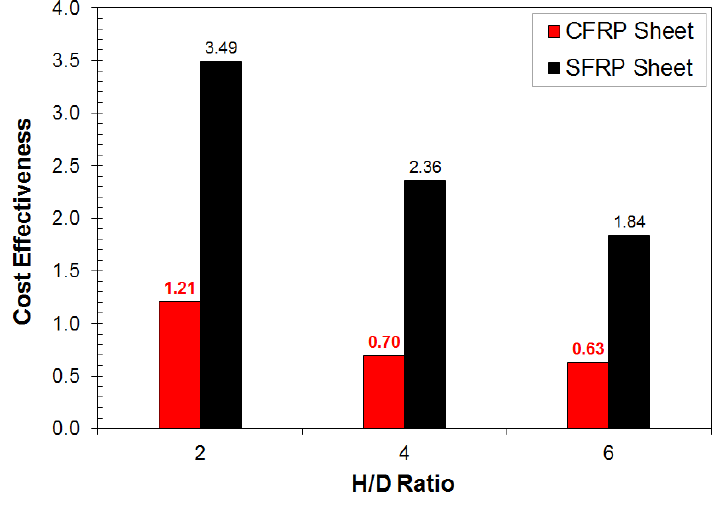
Figure 4. Cost effectiveness of the aspect ratio columns wrapped with SFRP and CFRP